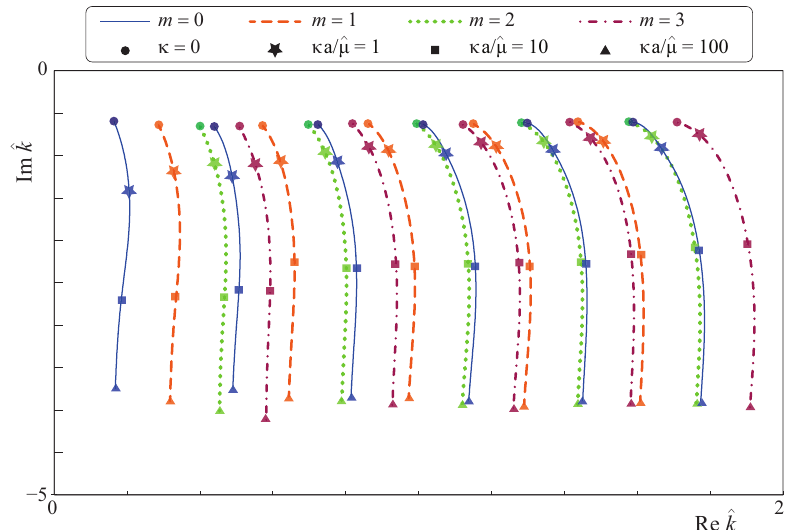
Figure 8. Eigenfrequencies ˆ k m n ( κ ) of a circular uniformly distributed delamination in the elastic space made of